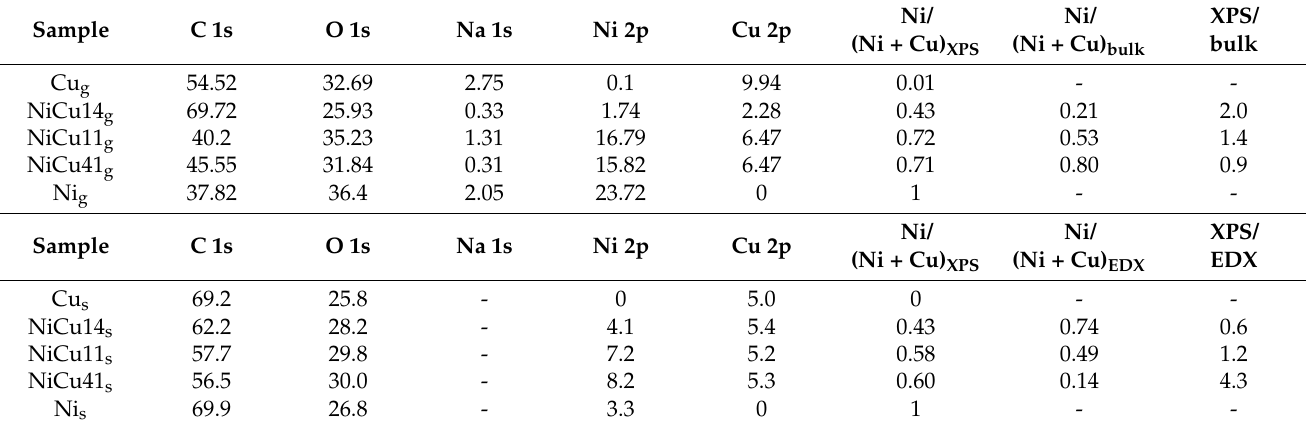
Table 5. XPS data (concentration of elements in at. %) of granular and sputtered catalysts and comparison of the XPS data of Ni and Cu elements with the chemical analysis of the catalysts by AAS (labelled as bulk) and